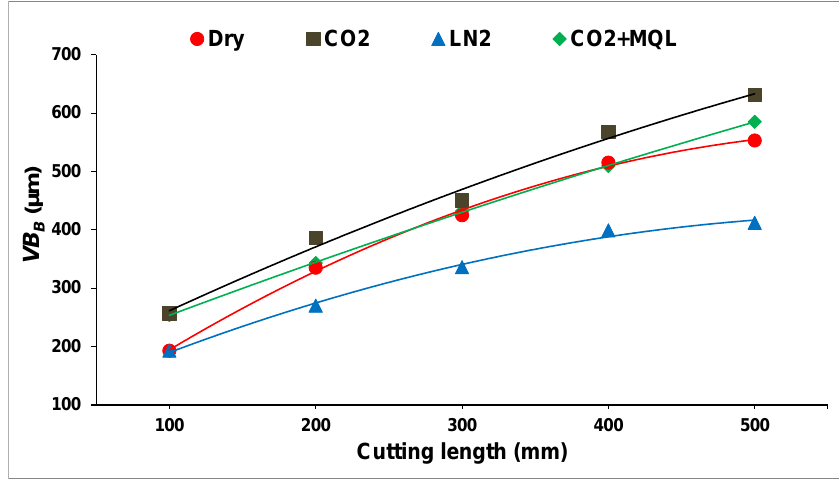
Figure 2. Progression of flank wear as a function of various conditions.